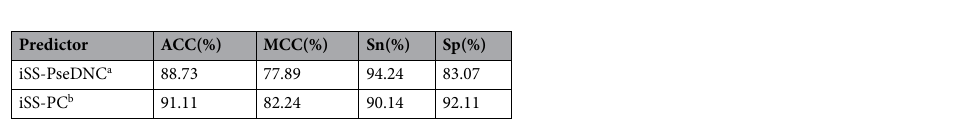
Table 4. The comparison of the 5-fold cross-validation test results on benchmark data-set only containing splice acceptor site sequences. a The prediction method developed by Wei Chen (2014). b The prediction method proposed in this